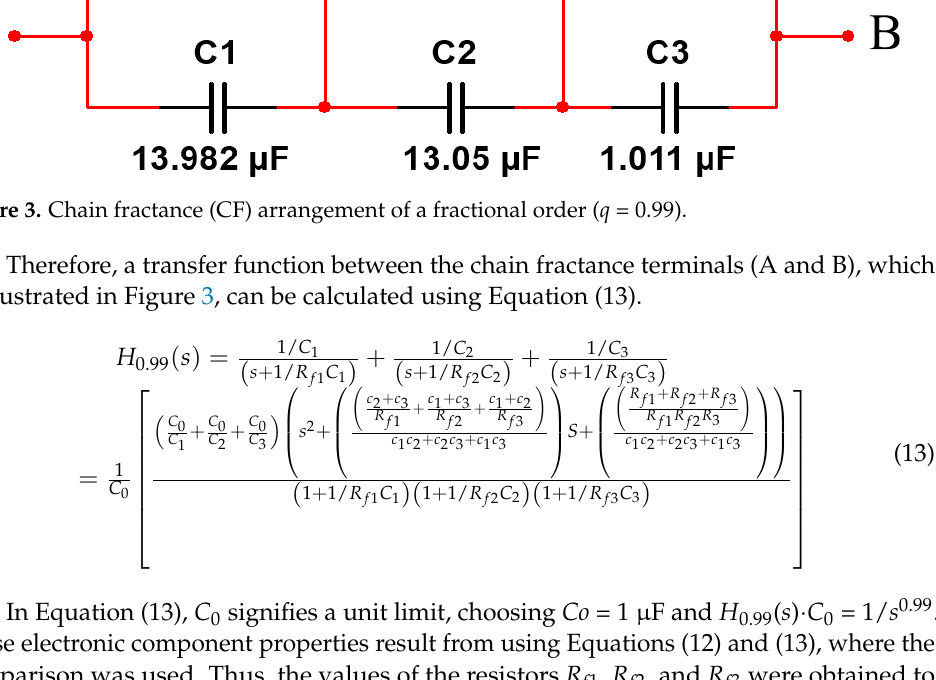
In Equation (13), C 0 signifies a unit limit, choosing Co = 1 µ F and H 0.99 ( s ) · C 0 = 1/ s 0.99 . These electronic component properties result from using Equations (12) and (13), where the comparison was used. Thus, the values of the resistors R f 1 , R f 2 , and R f 3 were obtained to be 95.082 M Ω , 6.441 k Ω , and 6.436 k Ω , respectively, while the values of the capacitors C 1 , C 2 , and C 3 were calculated to be 13.982, 13.05, and 1.011 µ F, as illustrated in Figure 3. The chain fractance scheme shown in Figure 3 has been employed to substitute the capacitor in the standard integer integrator arrangement to accomplish the fractional integration with order derivative value ( q = 0.99). As a result, based on the fractional-order memcapacitor described by Equation (11), the fractional-order memcapacitor circuit has been modelled to be as described by the fowling Equation (14):